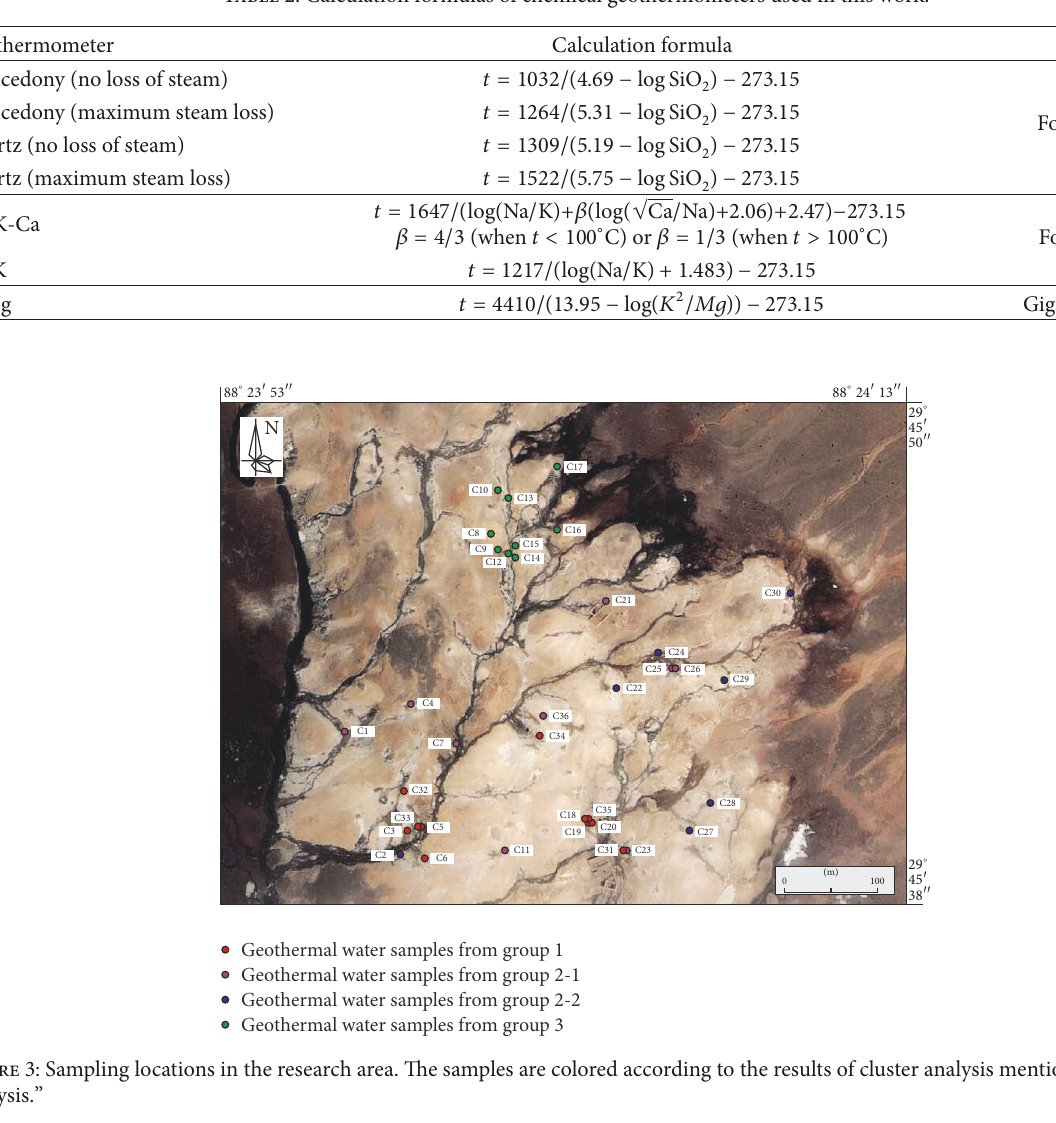
Table 2: Calculation formulas of chemical geothermometers used in this work.